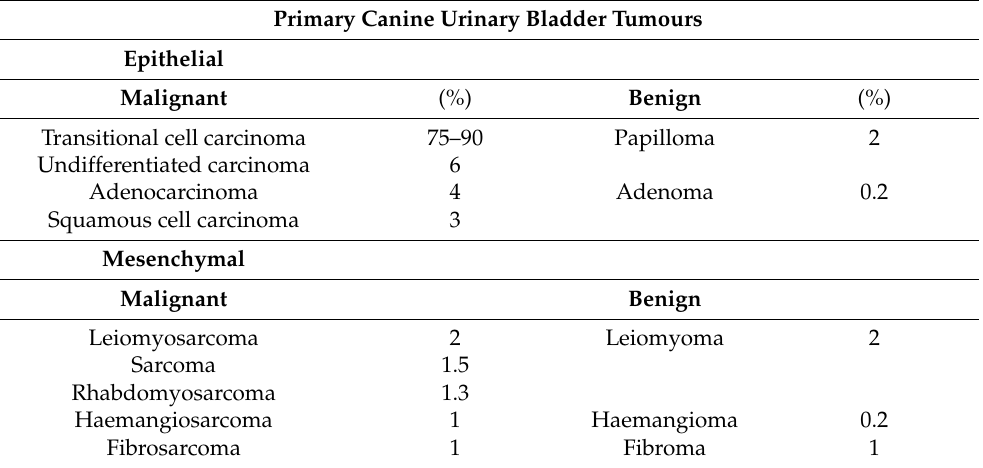
Table 1. Primary bladder tumours in dogs, types and percentages (the most common tumours reported are shown; adapted from Meuten and Meuten, 2016